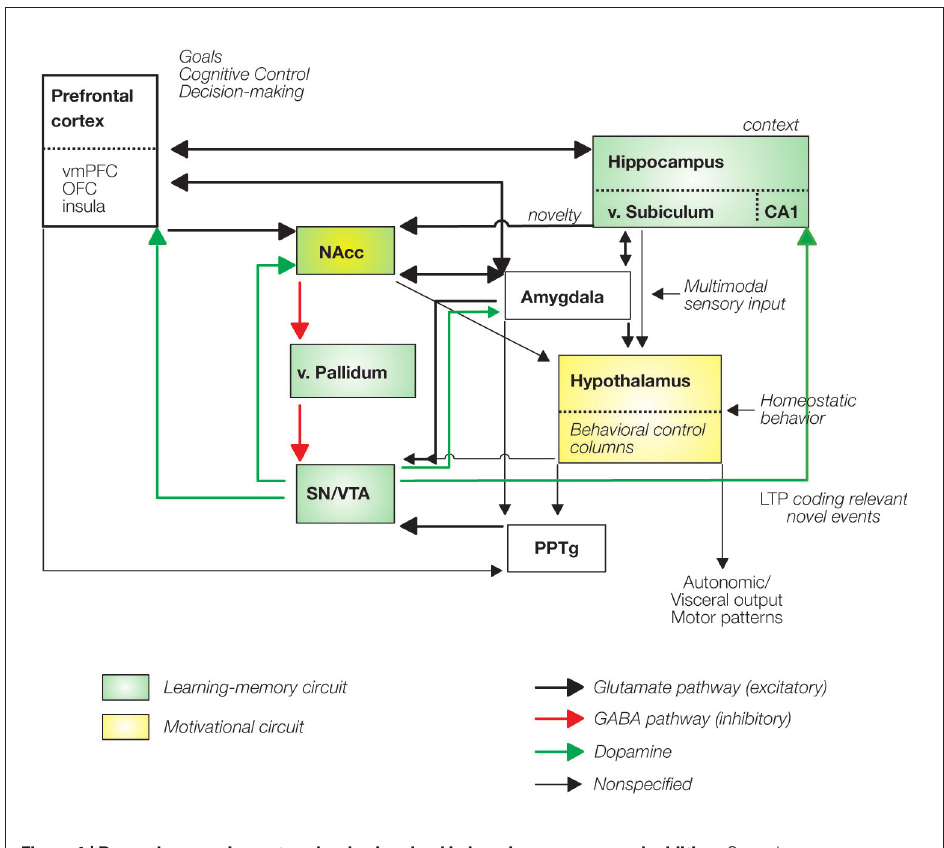
Figure 1 | Reward processing networks also involved in learning, memory and addition. Green boxes highlight the hippocampal-VTA learning-memory circuit described by Lisman and Grace (2005). The motivational system has been adapted from Kelley (2004) (yellow boxes). Notice that the direct and indirect projections from the hypothalamus to the neocortex–limbic structures through the dorsal thalamus is omitted from the figure. vmPFC, ventromedial prefrontal cortex; OFC, orbitofrontal cortex; PPTg, pedunculopontine tegmentum; LTP, long-term potentiation; v,